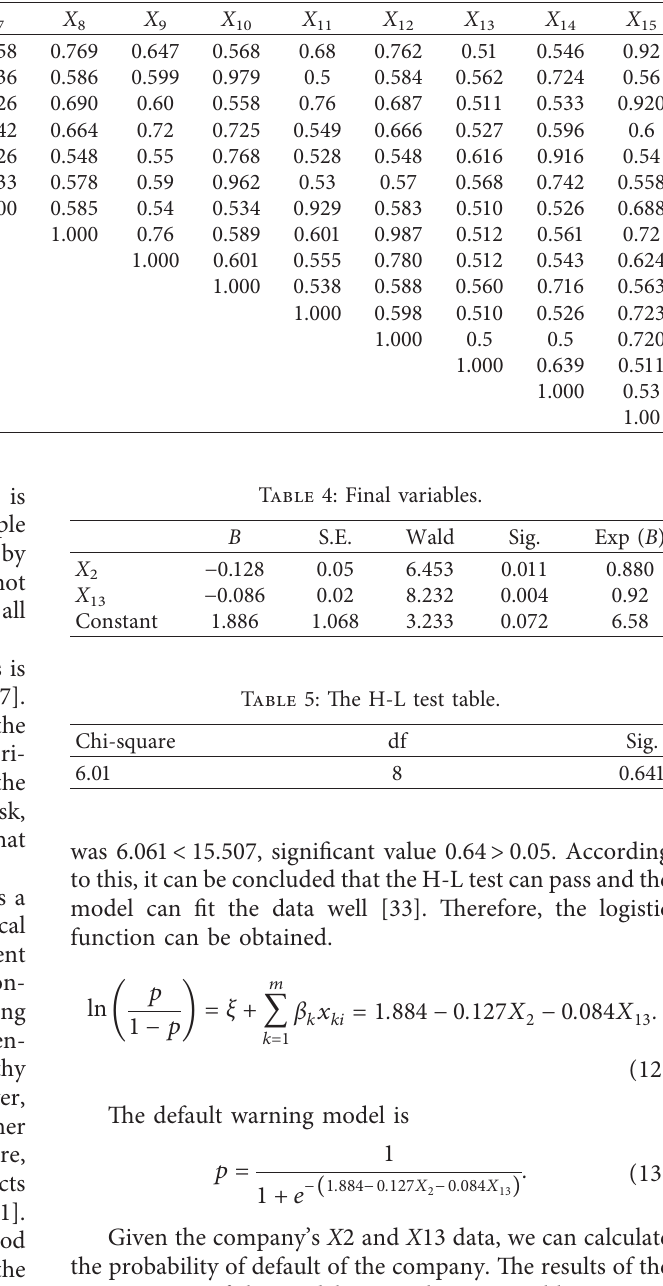
Table 3: Correlation matrix of financial indexes.